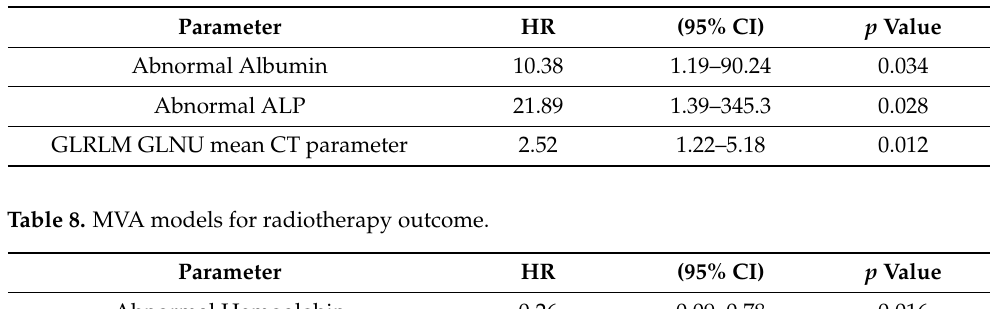
Table 7. MVA model for PFS outcome.